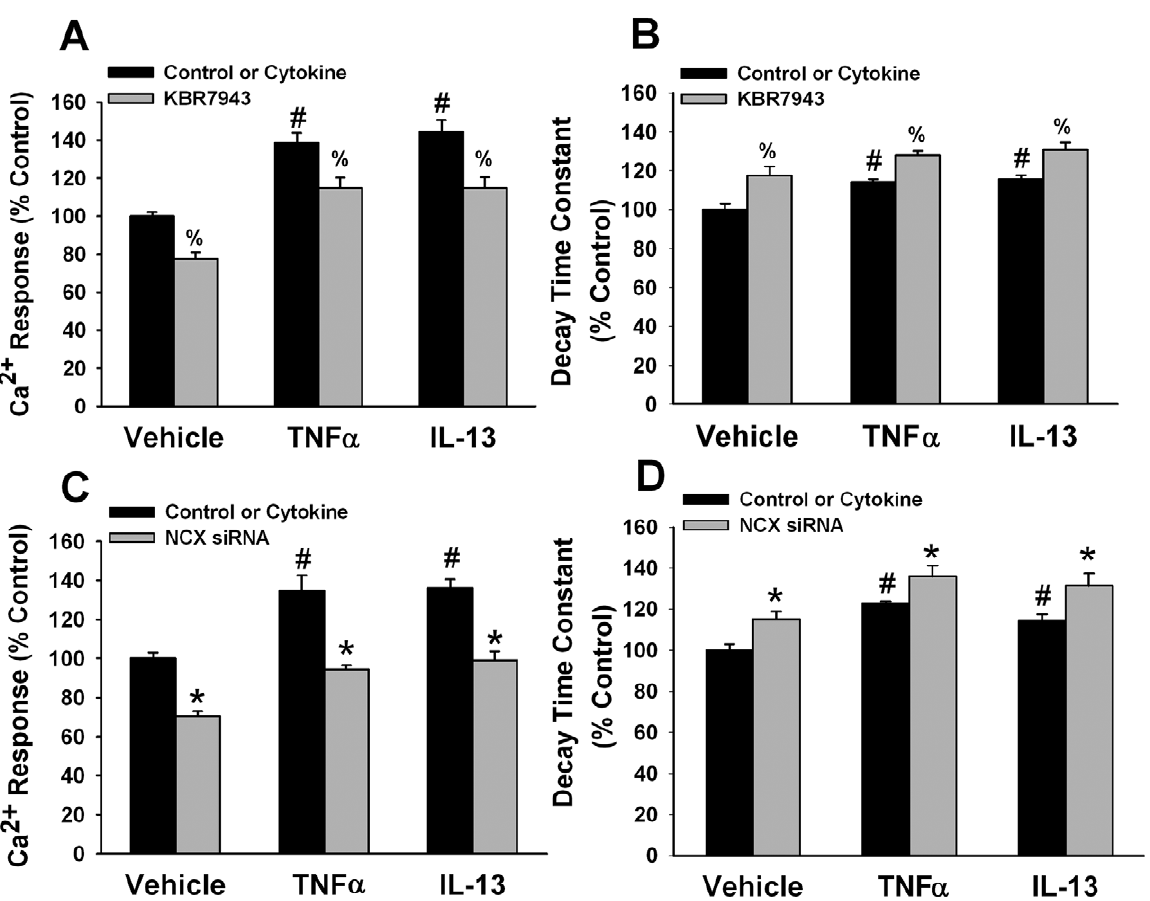
Figure 10. NCX in agonist-induced [Ca 2 + ] i responses. In ASM cells, 10 m M histamine stimulation resulted in the characteristic transient [Ca 2 + ] i response with high peak Ca 2 + followed by decay to a lower plateau. (A) Peak [Ca 2 + ] i responses to histamine were significantly decreased by inhibition of NCX using KBR7943. In cells exposed to TNF a or IL-13, peak [Ca 2 + ] i responses were significantly increased, while KBR7943 blunted these effects. (B) The decay of [Ca 2 + ] i (fitted to single exponential with calculation of a time constant) was slowed by KBR7943 in cells exposed to vehicle, TNF a or IL- 13; however these effects were smaller than KBR7943 effects on peak [Ca 2 + ] i . Transfection with NCX1 siRNA also substantially blunted peak [Ca 2 + ] i (C) and slowed the decay of [Ca 2 + ] i responses (D) to histamine in vehicle- and cytokine-treated ASM cells. Values are means 6 SE. (n=5 patient samples for controls, 3 patient samples for cytokine groups; minimum 50 cells per bar). % indicates significant KBR7943 effect, * significant NCX1 siRNA effect, and # significant cytokine effect, (p ,